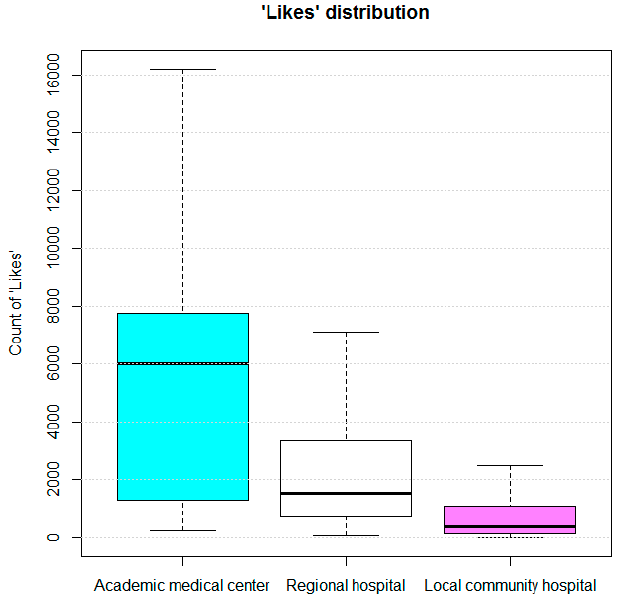
Figure 1. “Likes” distribution of official Facebook fan pages of 213 hospitals in Taiwan.